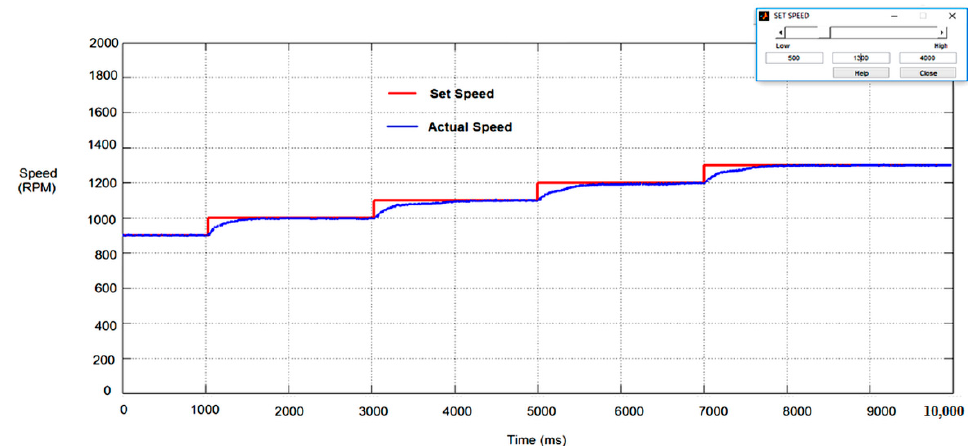
10 of 12 Figure 12. Brushless DC motor drive hardware arrangements.